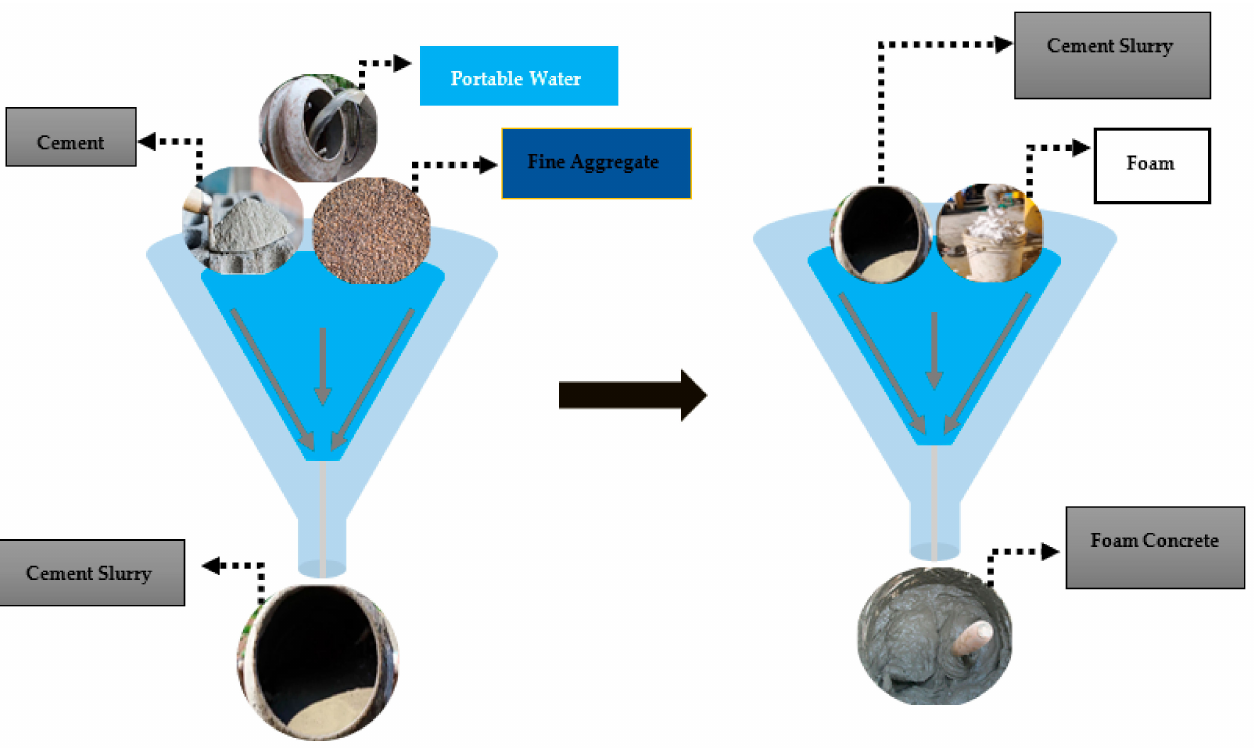
Figure 3. Materials used to Produce Foam